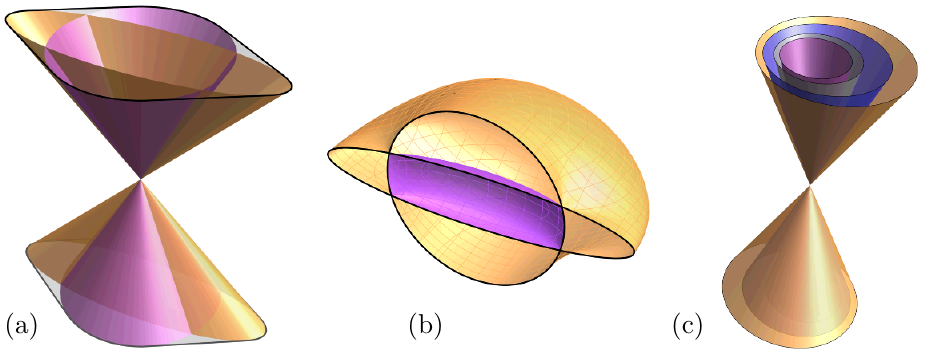
Figure 4 . Some hyperbolic systems of physical signi(cid:12)cance: (a) the ray cone of Maxwell’s equations for crystal optics in 2+1 dimensions, (b) the section of the ray surface for the crystal optics example in 3+1 dimensions, and (c) a symmetric hyperbolic system obtained from the 3+1 form of the Einstein (cid:12)eld equations. See appendix A for